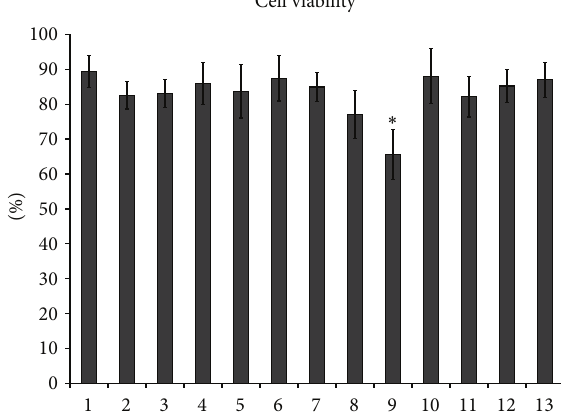
Figure 2: Effects of alcohol and drugs on hepatocyte viability. 1: control cells, 2: ethanol, 3: butanol, 4: wortmannin, 5: LY294002, 6: propranolol, 7: halopemide, 8: C6-ceramide, 9: doxorubicin, 10: myriocin, 11: imipramine, 12: GW4869, 13: total sphingolipid turnover inhibitors. ∗ 𝑝 < 0.05 , drug versus